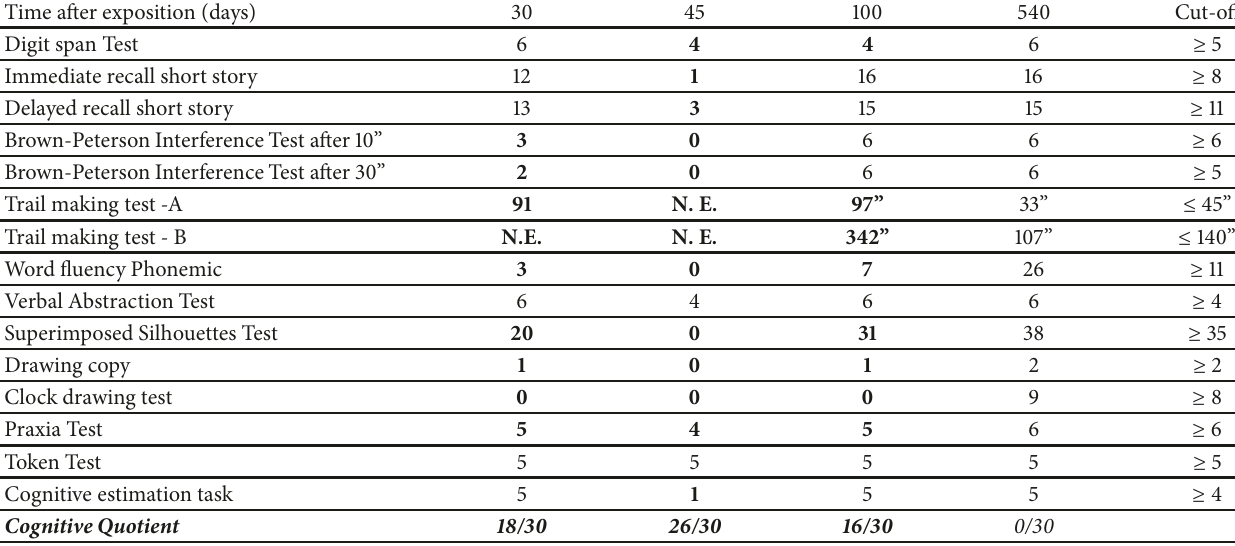
Table 1: Neuropsychological profile at different times after